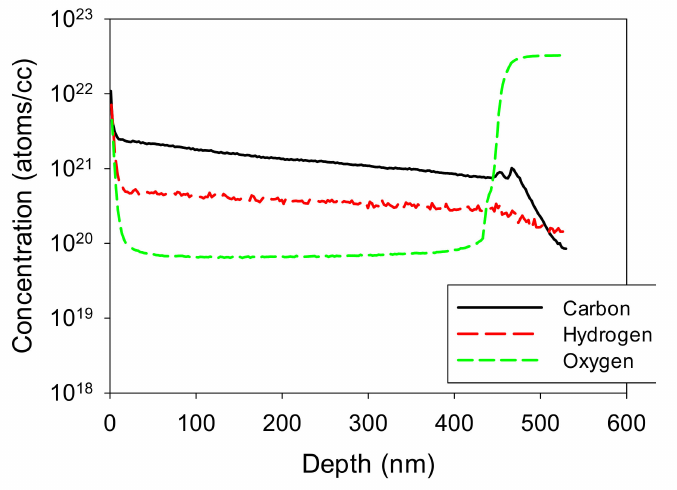
Figure 11. SIMS data for high-carbon film shown in Figure